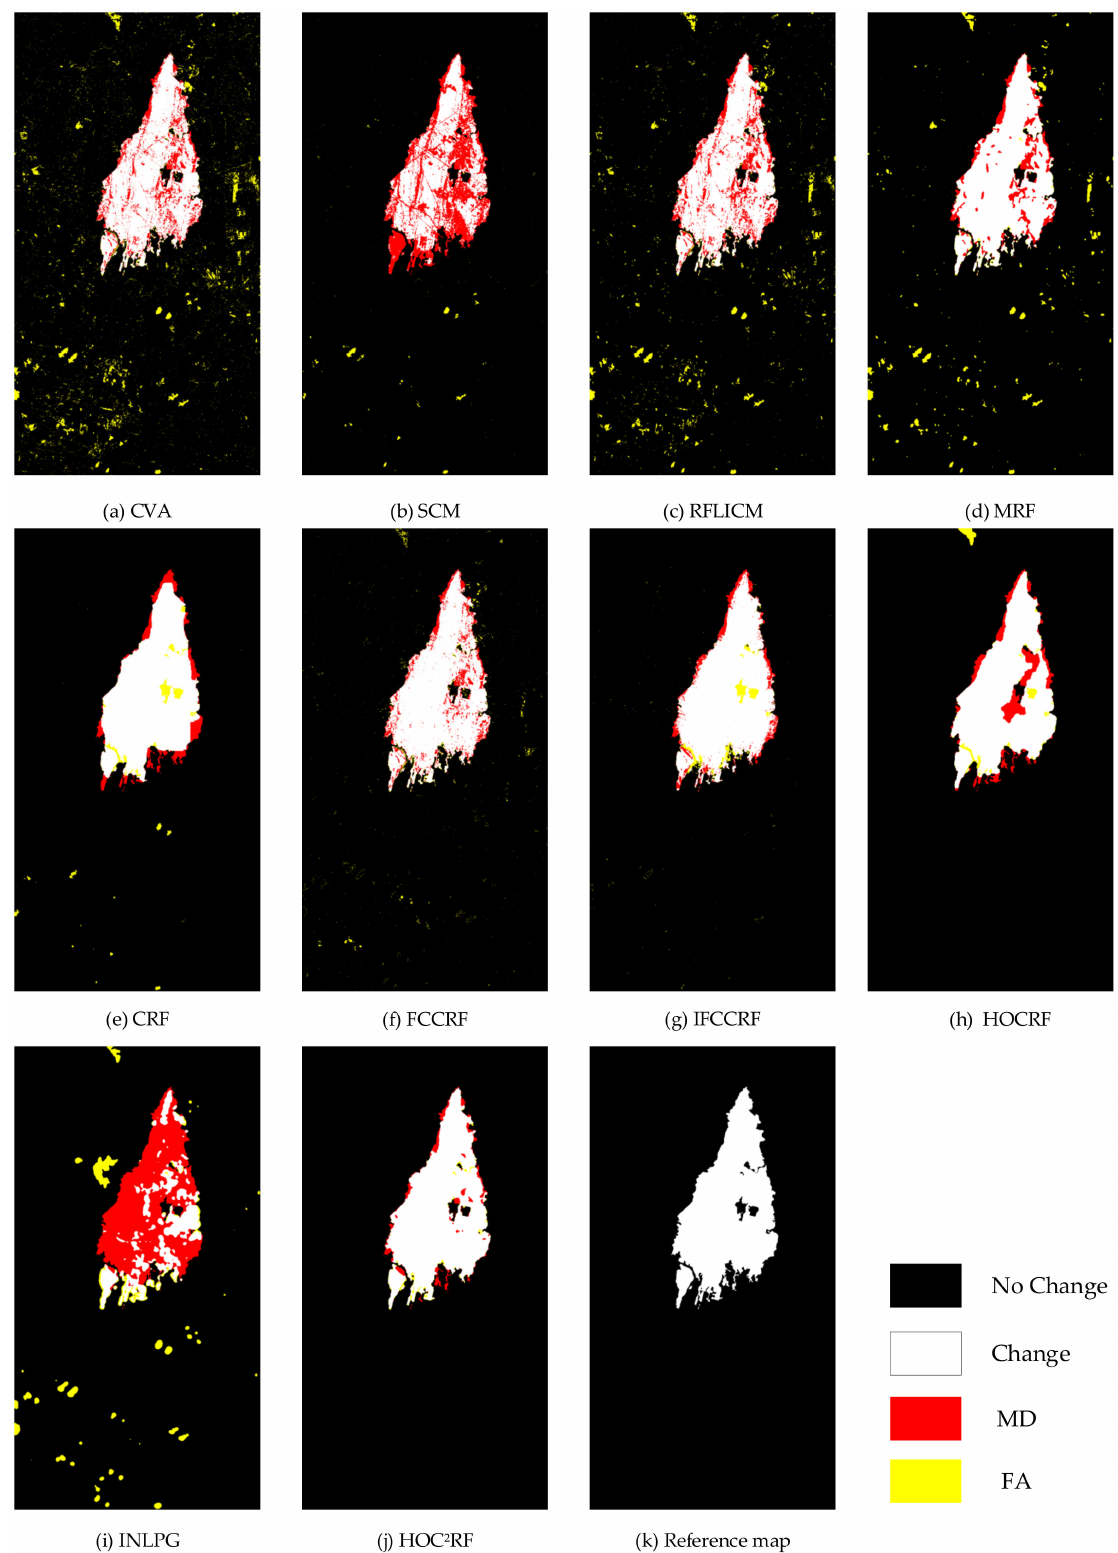
Figure 7. CD maps produced by different methods for the Texas